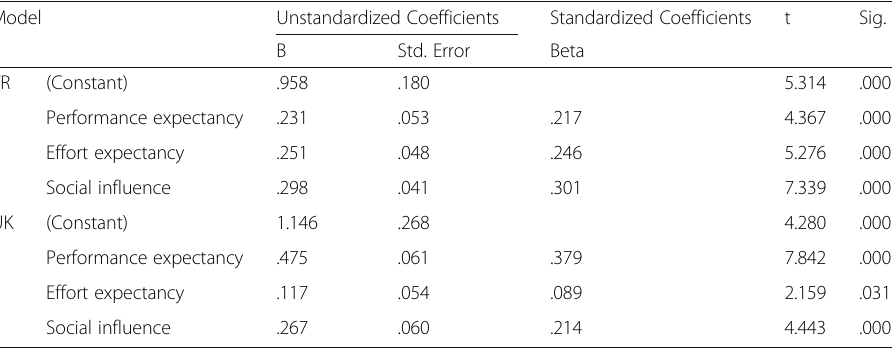
Table 4 Regression analysis results